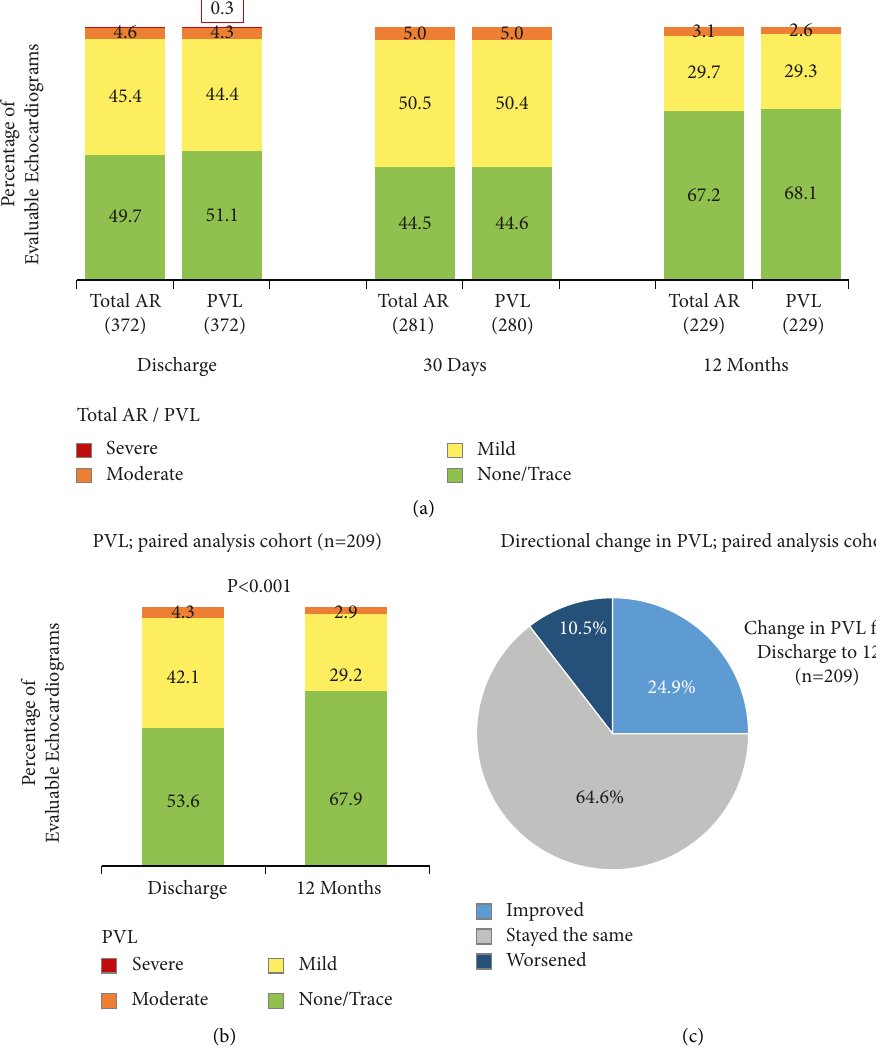
Figure 3: Improvement in aortic regurgitation. (a) The primary endpoint of PROGRESS PVL was the rate of total aortic regurgitation (AR), assessed by an independent echocardiography laboratory at discharge/7 days, 30 days, and 12 months in patients treated with ACURATE neo . Paravalvular leak (PVL) was very similar to total AR at all time points. (b, c) Paired analyses performed in patients with data available at both discharge and 12 months ( N � 209) demonstrated significant overall improvement in PVL ( P < 0 . 001; Bhapkar’s test for marginal homogeneity), with a greater proportion of patients showing interindividual improvement in PVL compared with worsening PVL. All echocardiographic data were assessed by a core